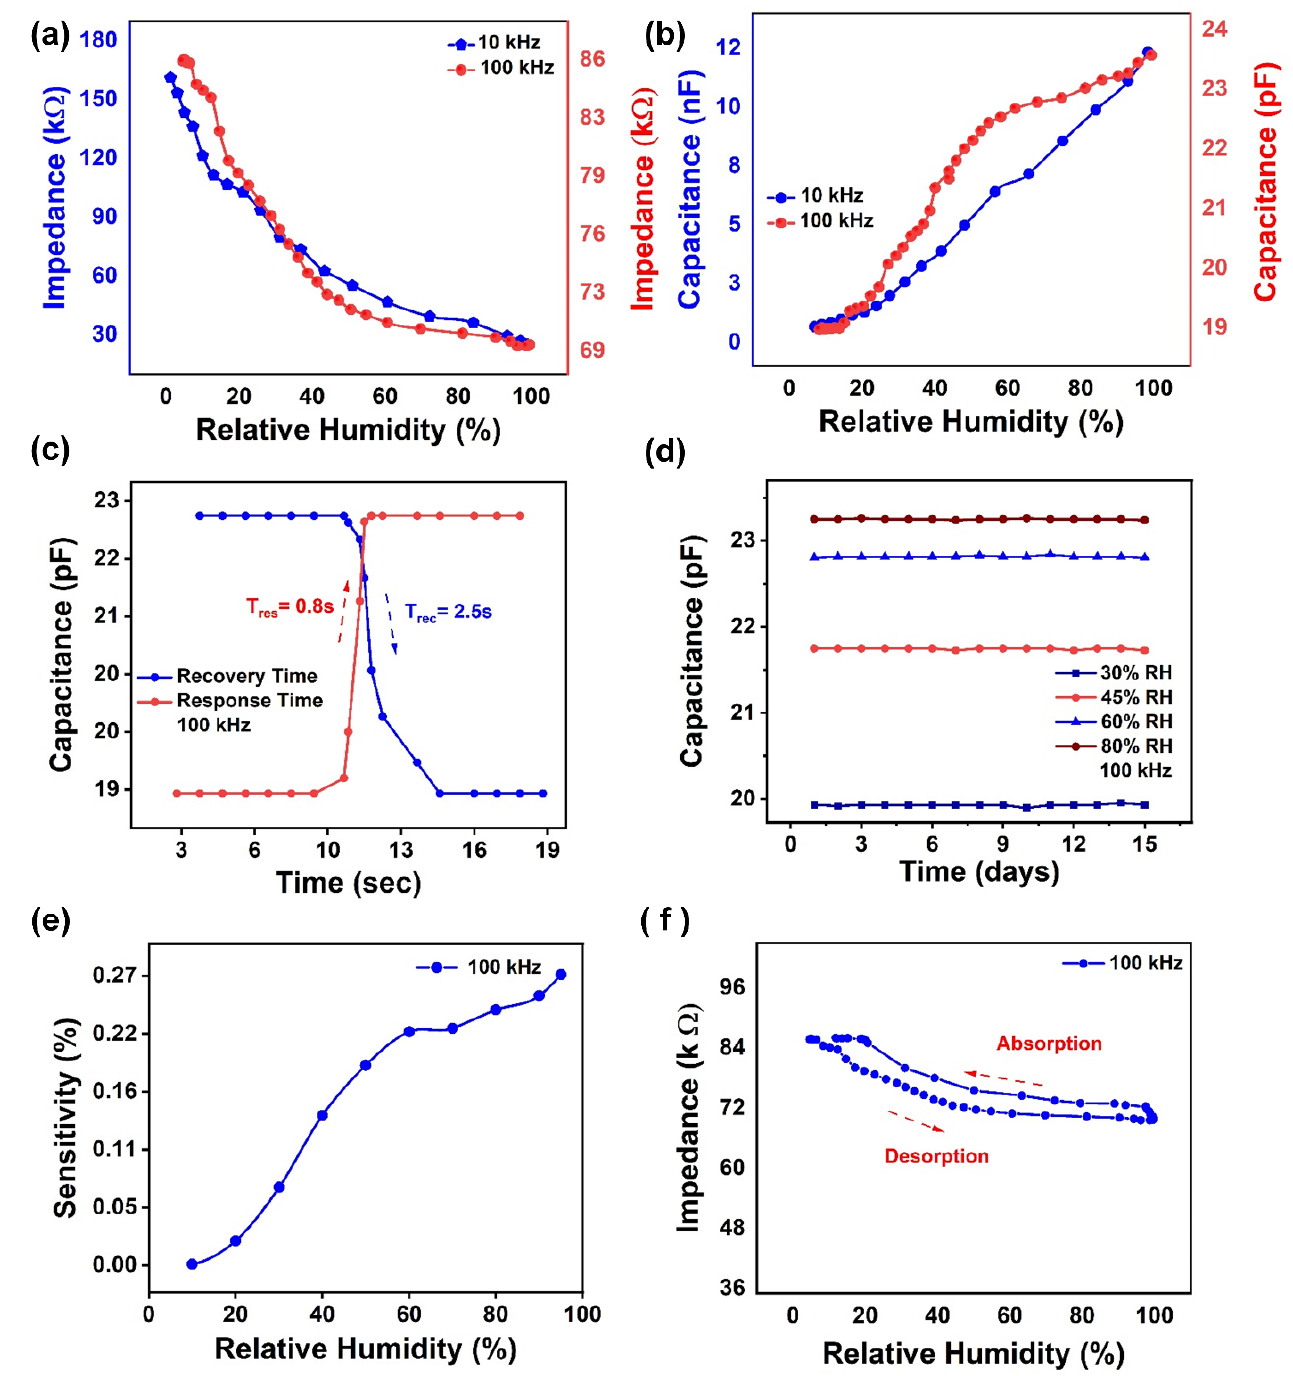
Figure 3. ( a ) Impedance response of the proposed humidity sensor at 10 kHz and 100 kHz. ( b ) Capacitance response of the proposed humidity sensor at 10 kHz and 100 kHz. ( c ) Capacitance response and recovery time of proposed humidity sensor at 10 kHz. ( d ) Capacitance stability of proposed humidity sensor over 15 days. ( e ) Capacitance sensitivity of proposed humidity sensor. ( f ) Hysteresis of the proposed sensor during absorption and desorption.